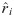
Fitness of virus variants and effective population size estimates for the 15 plant genotypes.(A) Estimates of intrinsic rates of increase r^i for each variant i for the DH lines 2321, 240, 2430, 2367, 2328, 2426, 2344 and 221. (B) Estimates of effective population size N^e(t) during the time course of the experiment for the DH lines listed in (A) and the model best supported by the data. (C) As for (A) for DH lines 2400, 2123, 2264, 2349, 219, 2256 and 2173. (D) As for (B) for the DH lines listed in (C).